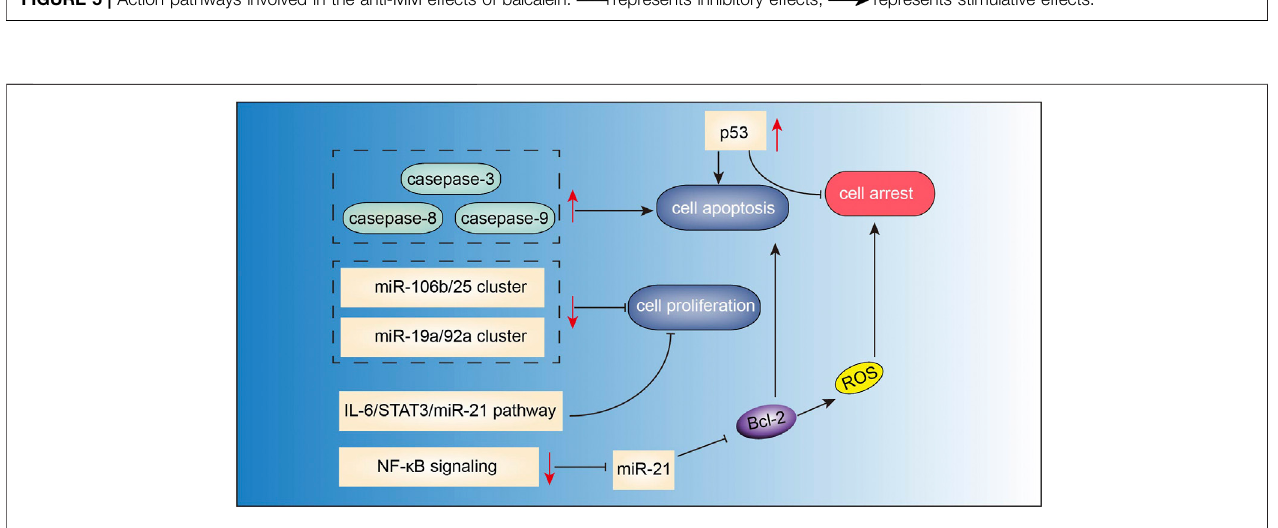
FIGURE 5 | Action pathways involved in the anti-MM effects of baicalein. represents inhibitory effects, represents stimulative effects.